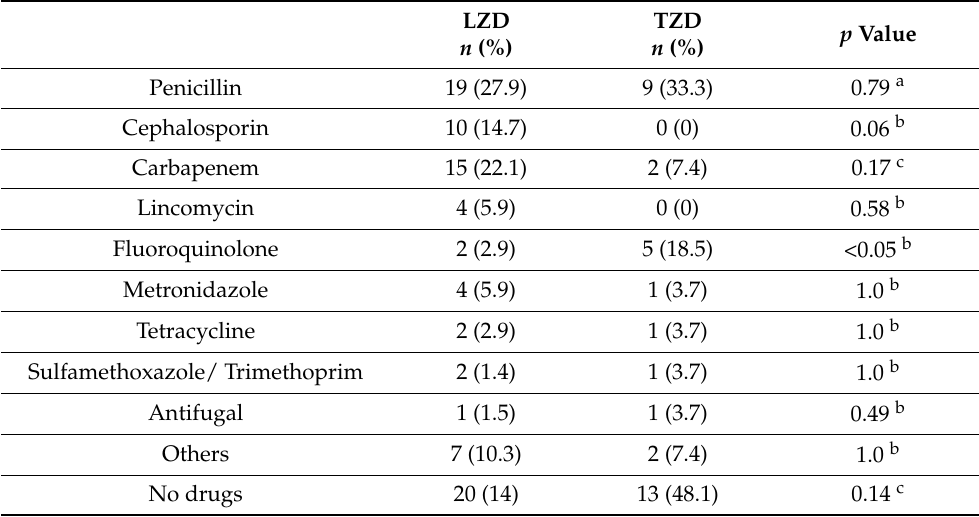
Table 3. Combination antimicrobial with oxazolidinone treatment.